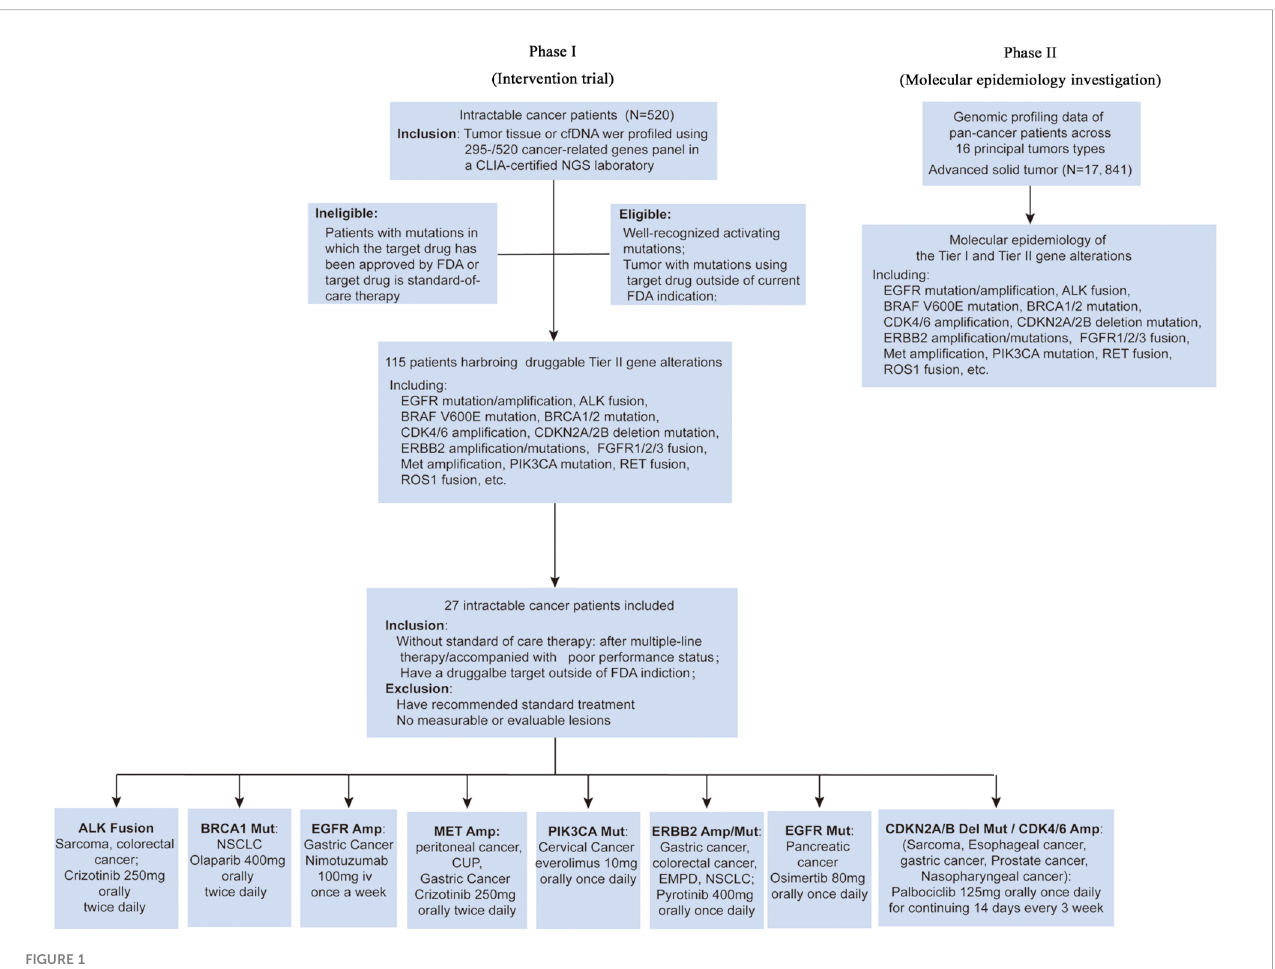
FIGURE 1 Long March Pathway